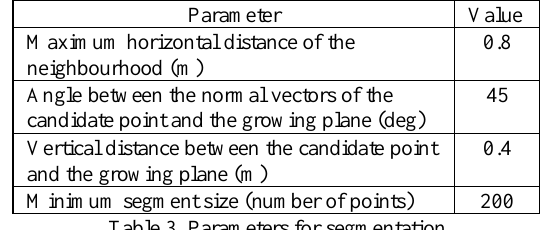
Table 3. Parameters for